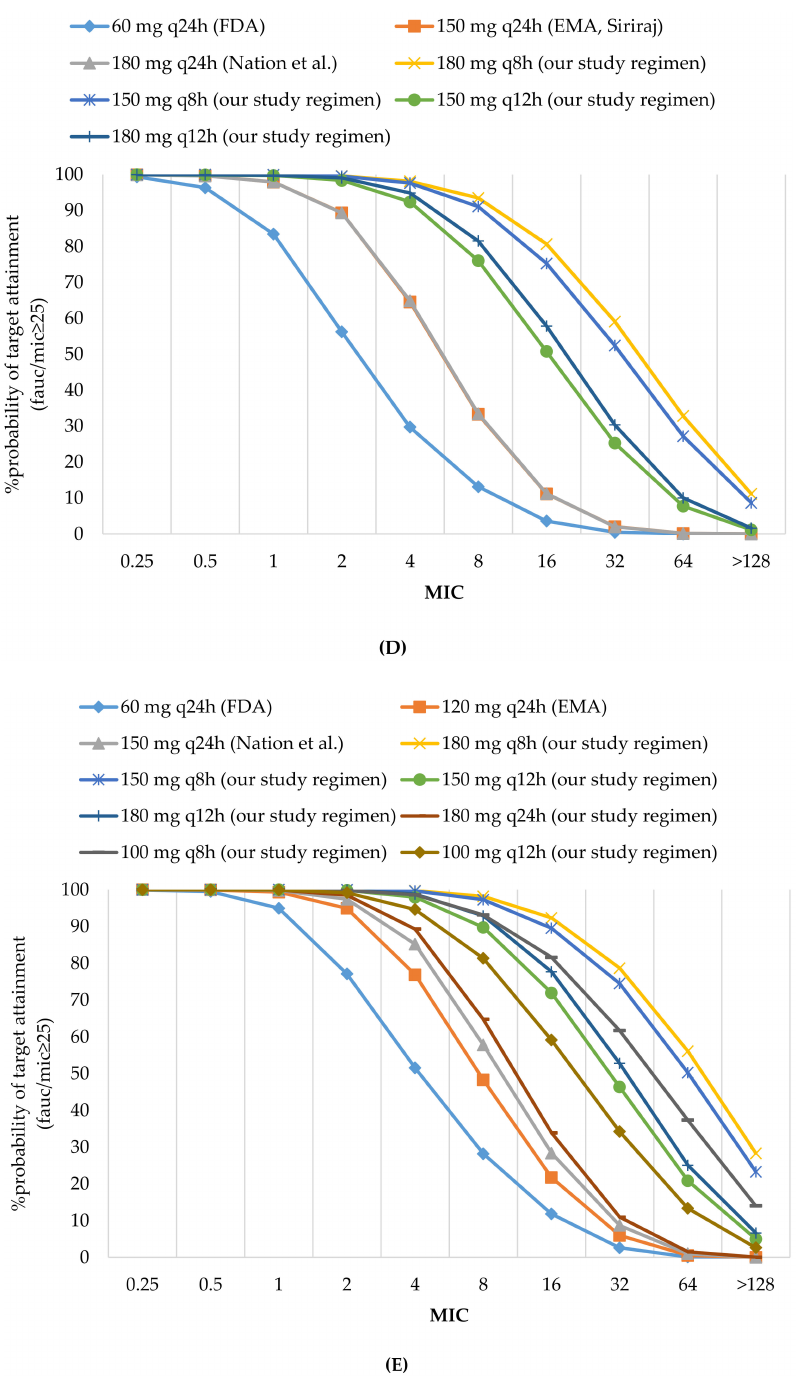
Figure 1. ( A ) %PTA of colistin in patients with CrCl ≥ 80 (mL / min). ( B ) %PTA of colistin in patients with CrCl 51–79 (mL / min). ( C ) %PTA of colistin in patients with CrCl 30–50 (mL / min). ( D ) %PTA of colistin in patients with CrCl 11–29 (mL / min). ( E ) %PTA of colistin in patients with CrCl ≤ 10 (mL / min). The alternative data of Figure ( D ) and ( E ) were shown in Supplementary Materials Figure S1 and